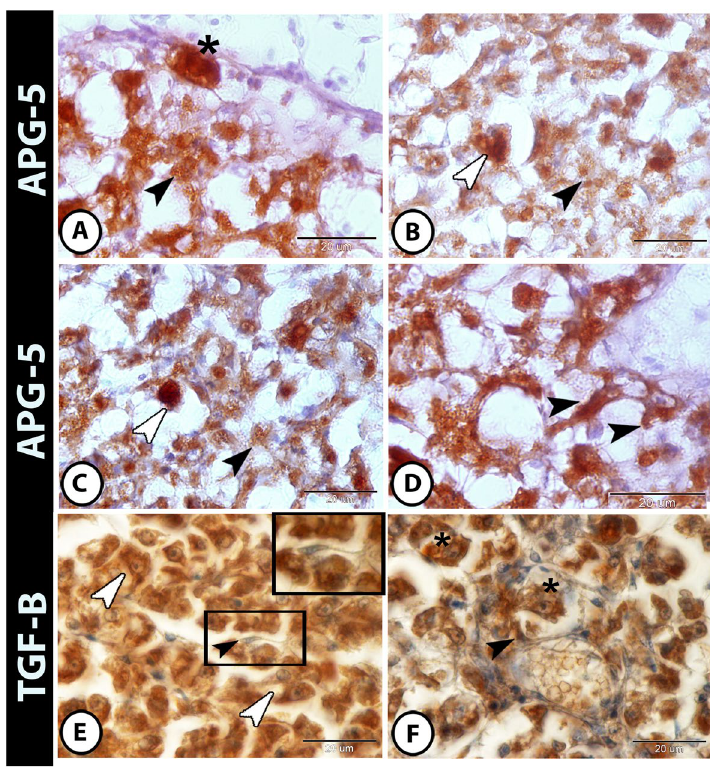
Fig. 3 The immunohistochemistry of APG5 and TGF-β in liver of molly fish A‑C The hepatocytes (black arrowheads) showed moderate to strong reactivity to APG5, while Kupffer cells (white arrowheads) and melanomacrophages (asterisks) showed strong reactivity to APG5. D Telocytes (black arrowheads) showed strong immunoreactivity to APG5 and connected to each other by their long telopodes. E and F TGF-β showed strong immunoreactivity in hepatocytes (white arrowheads), telocytes (black arrowheads), and macrophages